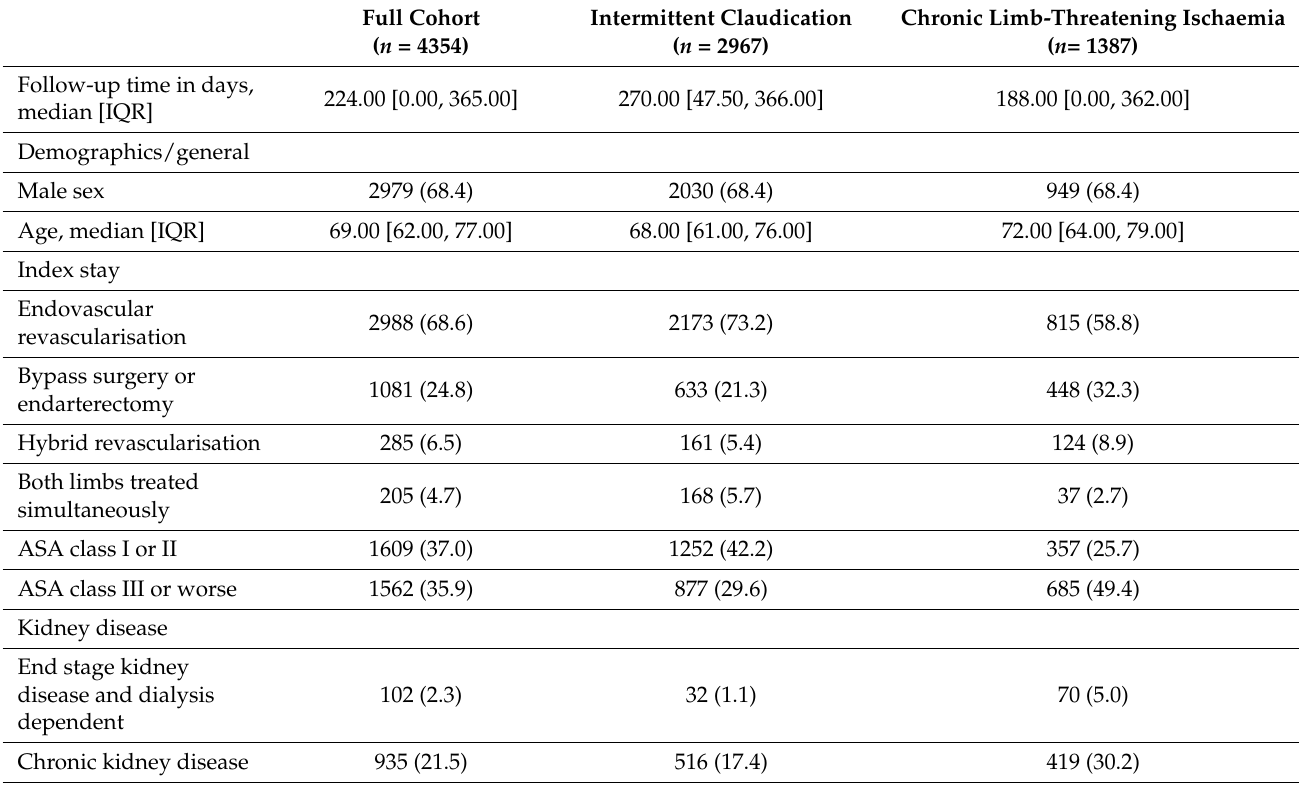
Table 1. Baseline characteristics of the full cohort stratified by severity of peripheral arterial occlusive disease. BMI: Body-mass-index, IQR: Interquartile range, ASA: American Society of